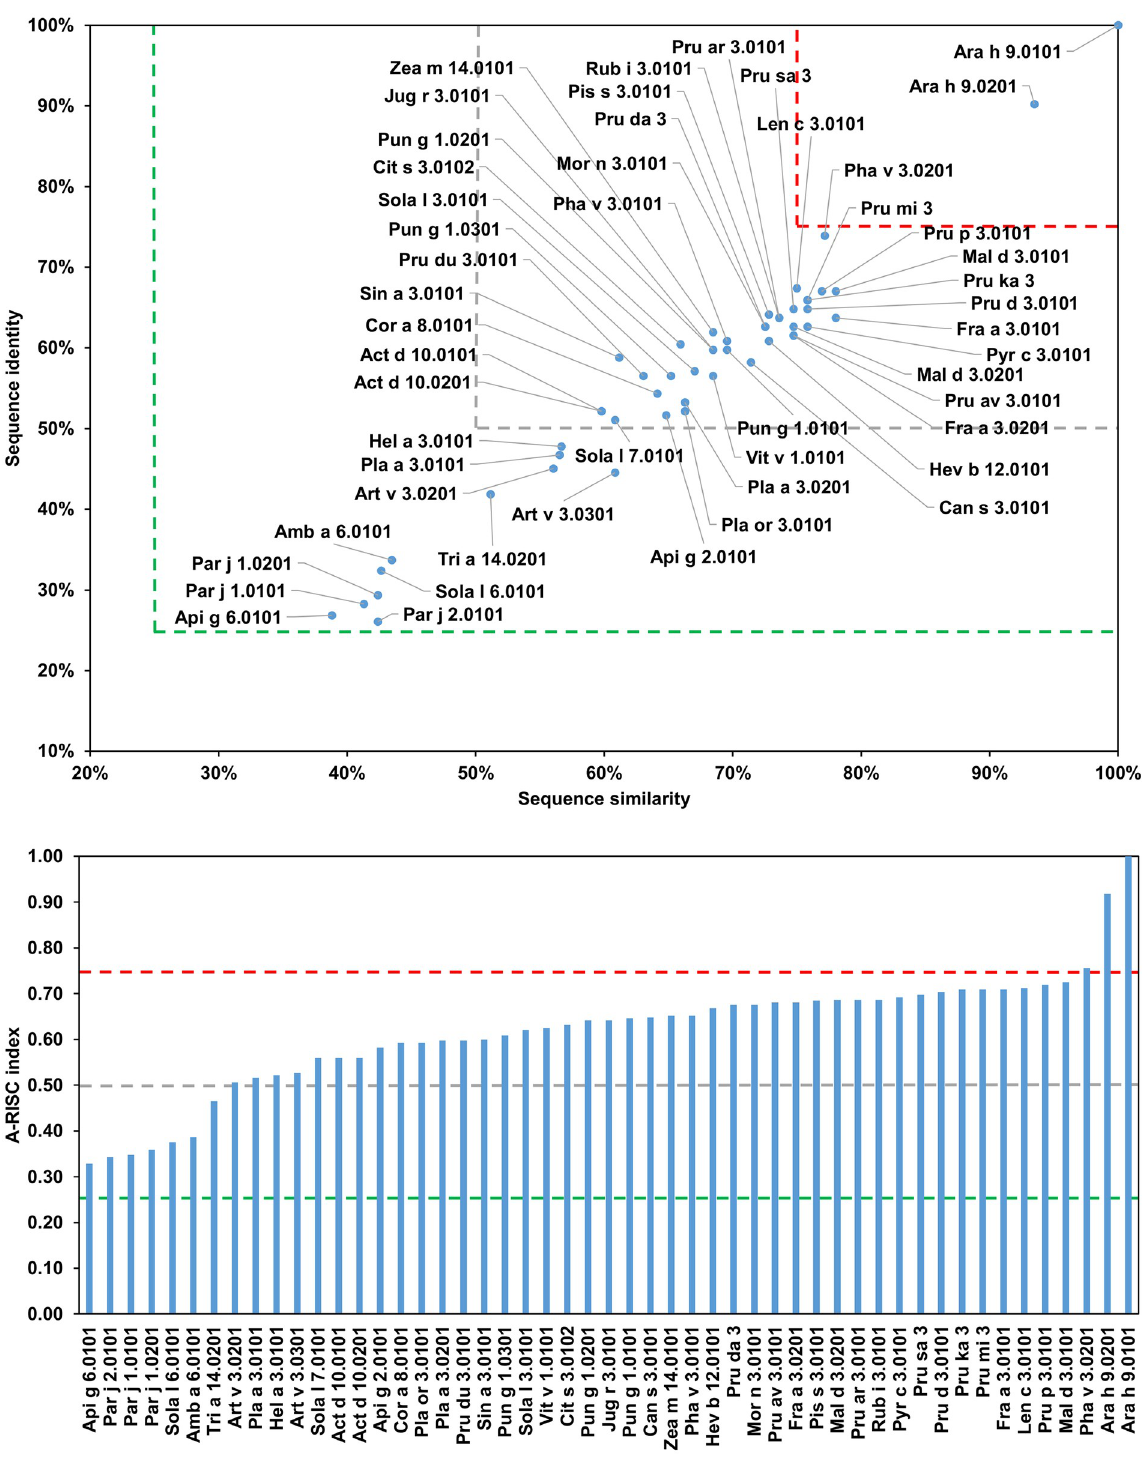
Fig 23. Plots showing relative homology and A-RISC indexes of allergens from nsLTP family. Comparison of the family members to Ara h 9.0101. Red, gray, and dark green dashed lines indicate respectively 75%, 50% and 25% sequence identity and similarity, or 0.75, 0.50 and 0.25 A-RISC